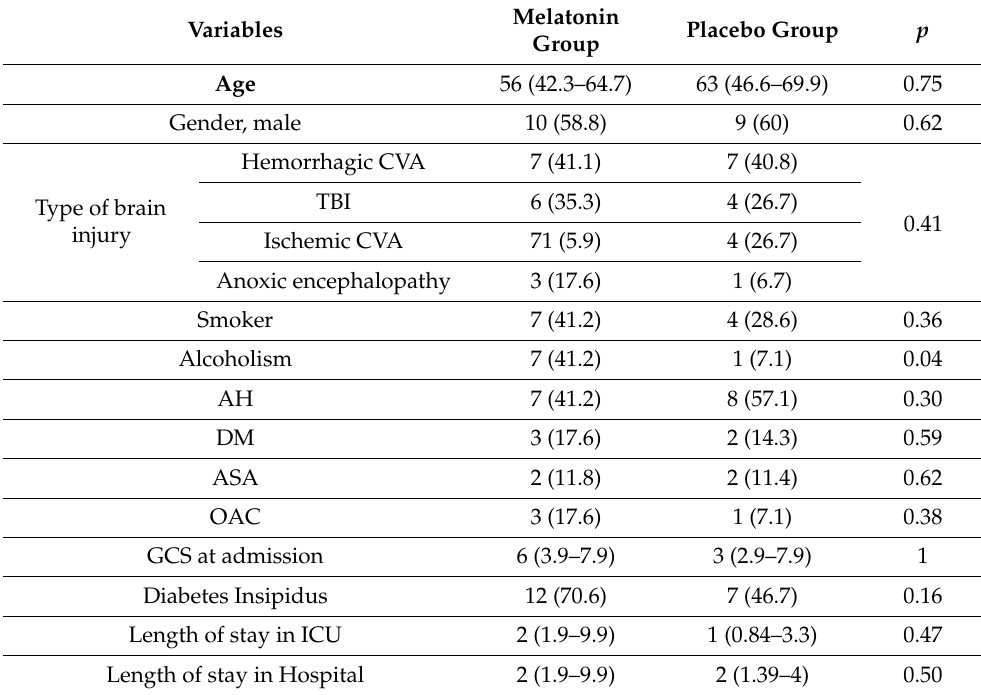
Table 1. Clinical variables of donation after brain death donors group.